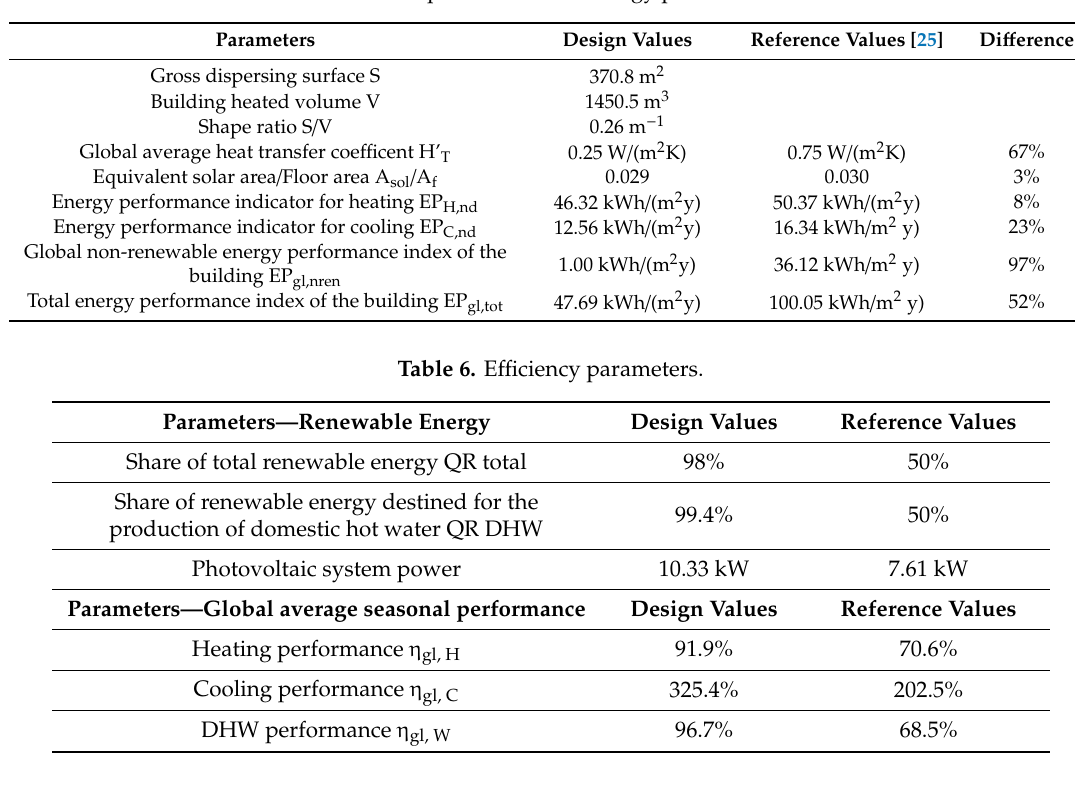
Table 5. Geometric parameters and energy performance indices.